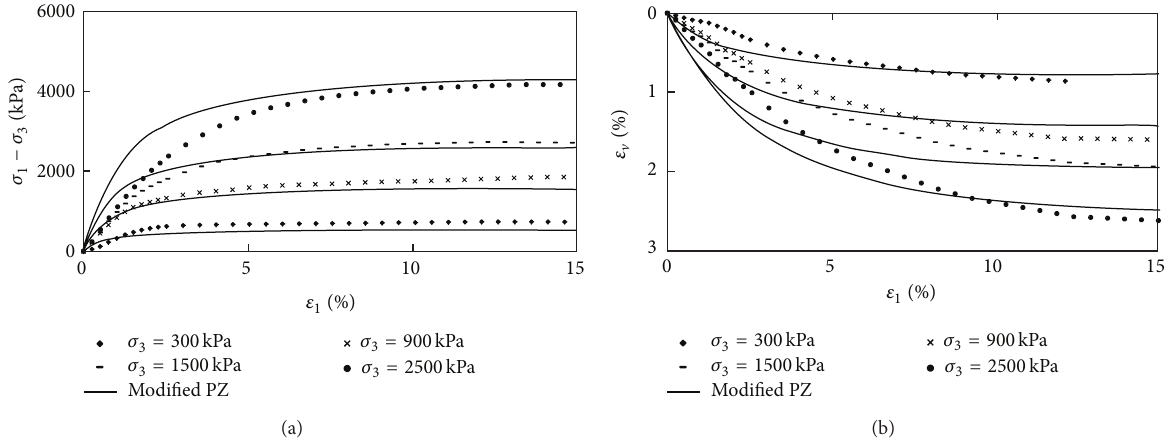
Figure 9: Comparison between fittings of the modified PZ-III model and experimental triaxial tests results for clay.